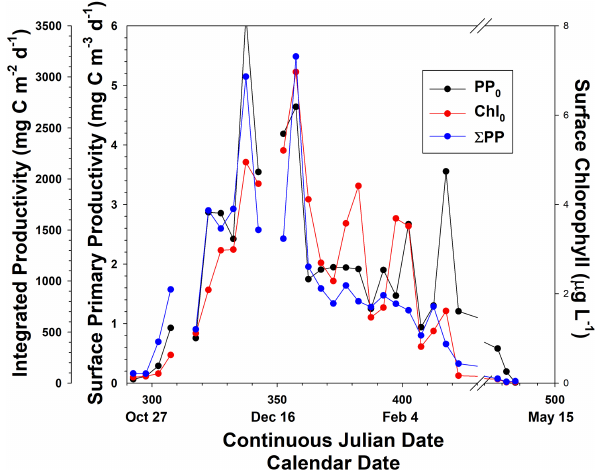
Figure 4. Temporal distribution of surface (PP 0 ) and integrated pri- mary productivity ( (cid:54) PP; through the 0.1% isolume) and surface chlorophyll concentrations (Chl 0 ). Data were binned in 5d inter- vals, and each bin had different numbers of samples (ranging from 2–27 values in each bin). Gaps in time were periods when no data were collected.